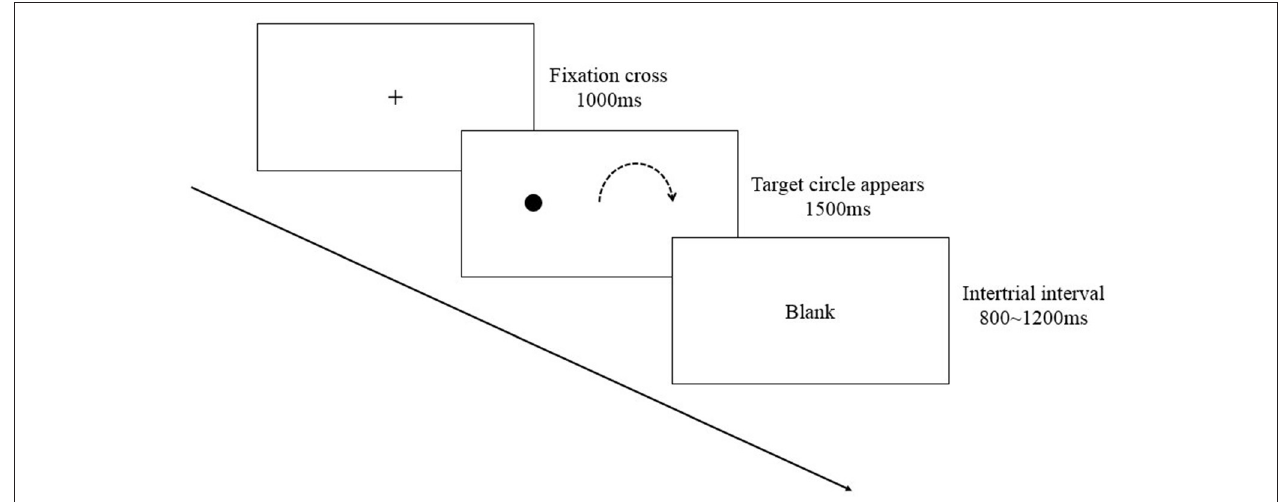
FIGURE 1 | The illustration of the antisaccade task.